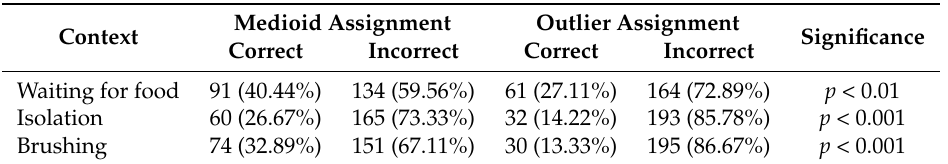
Table 1. Absolute frequencies (and percentages) of correct or incorrect assignment of medioid or outlier meows in each of the three contexts. Significance levels refer to differences between the rate of correct assignment of medioid vs. outlier meows within each context.